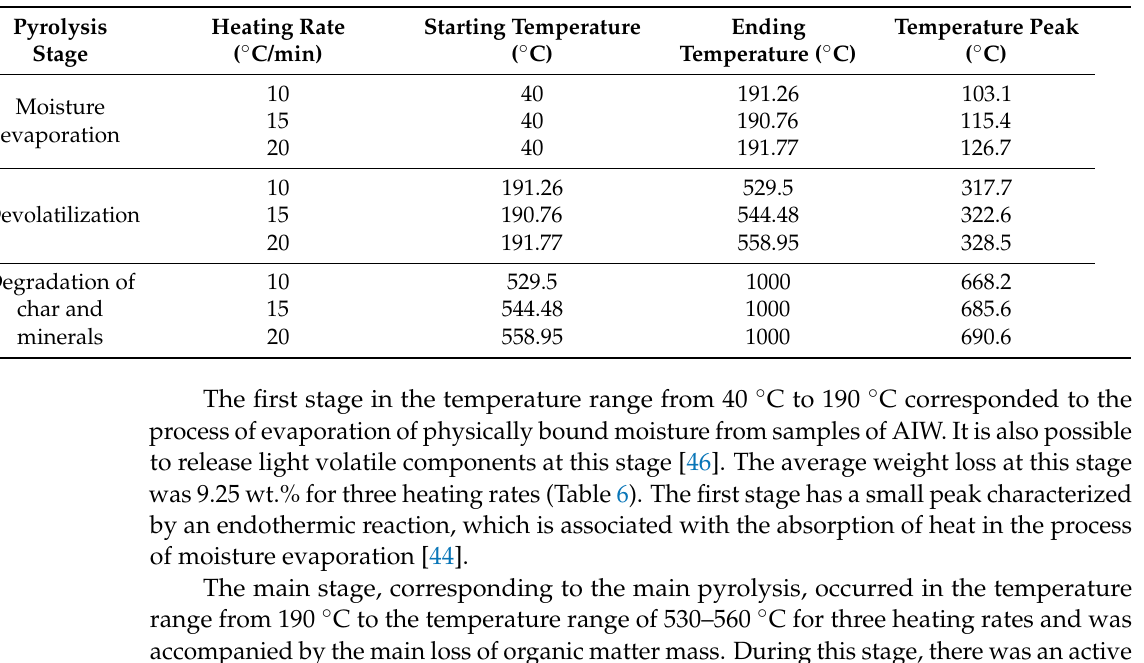
Table 5. Main stages of thermal